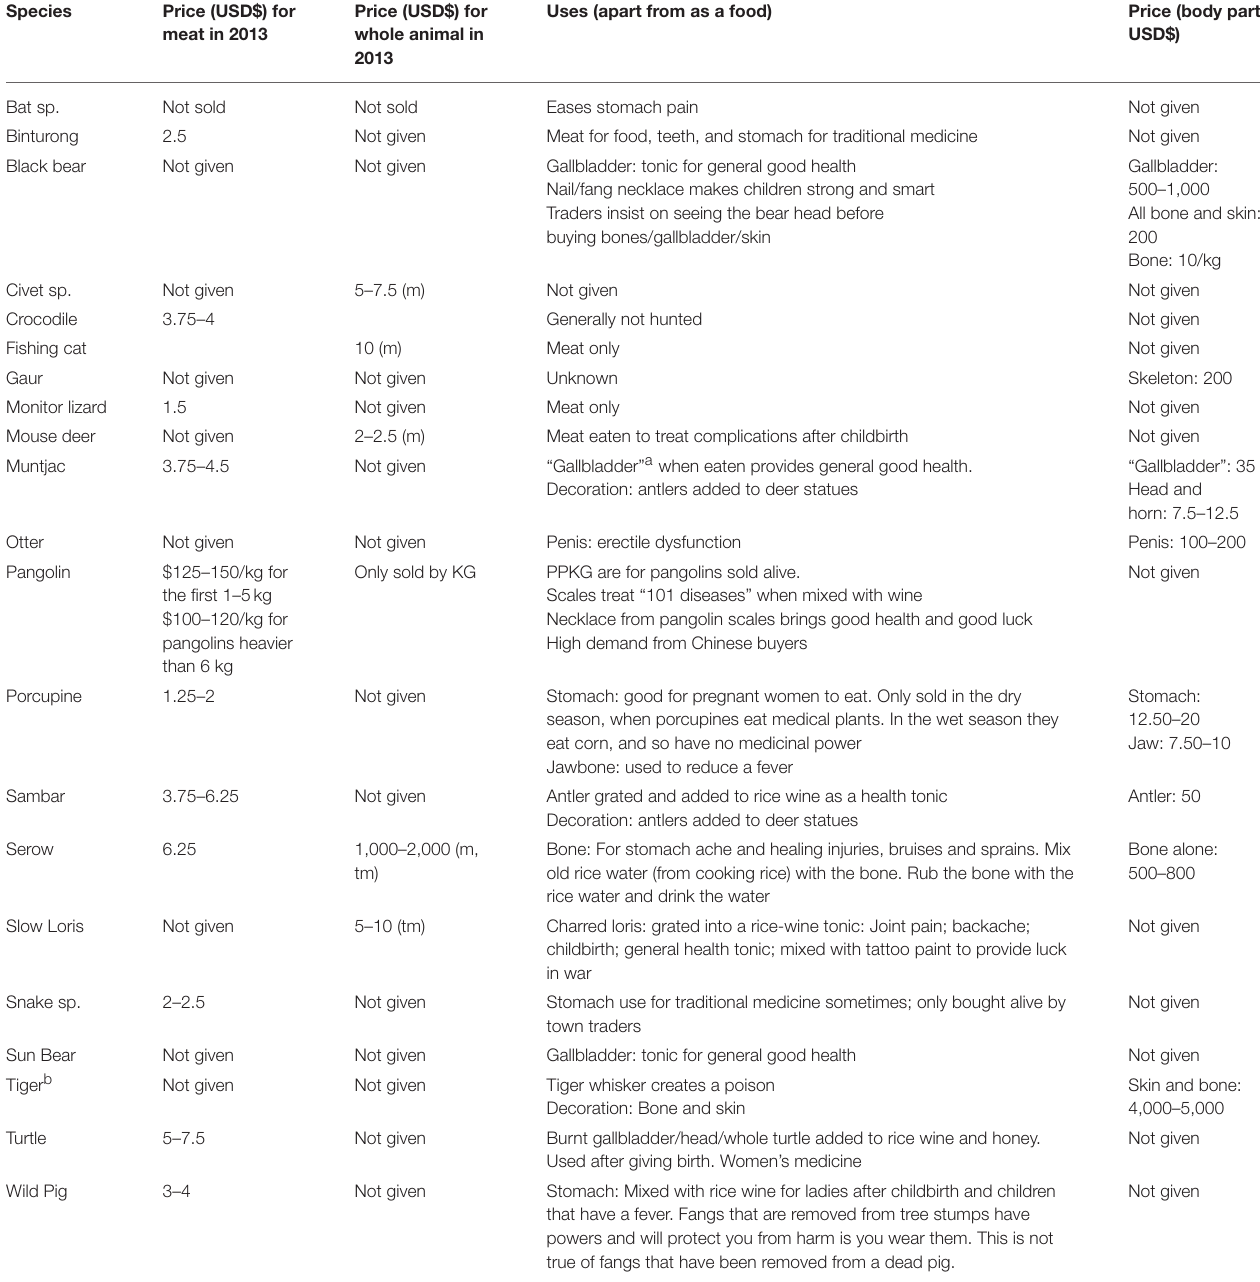
TABLE 1 | Uses and prices of wild meat species (from hunter and household interviews). Species